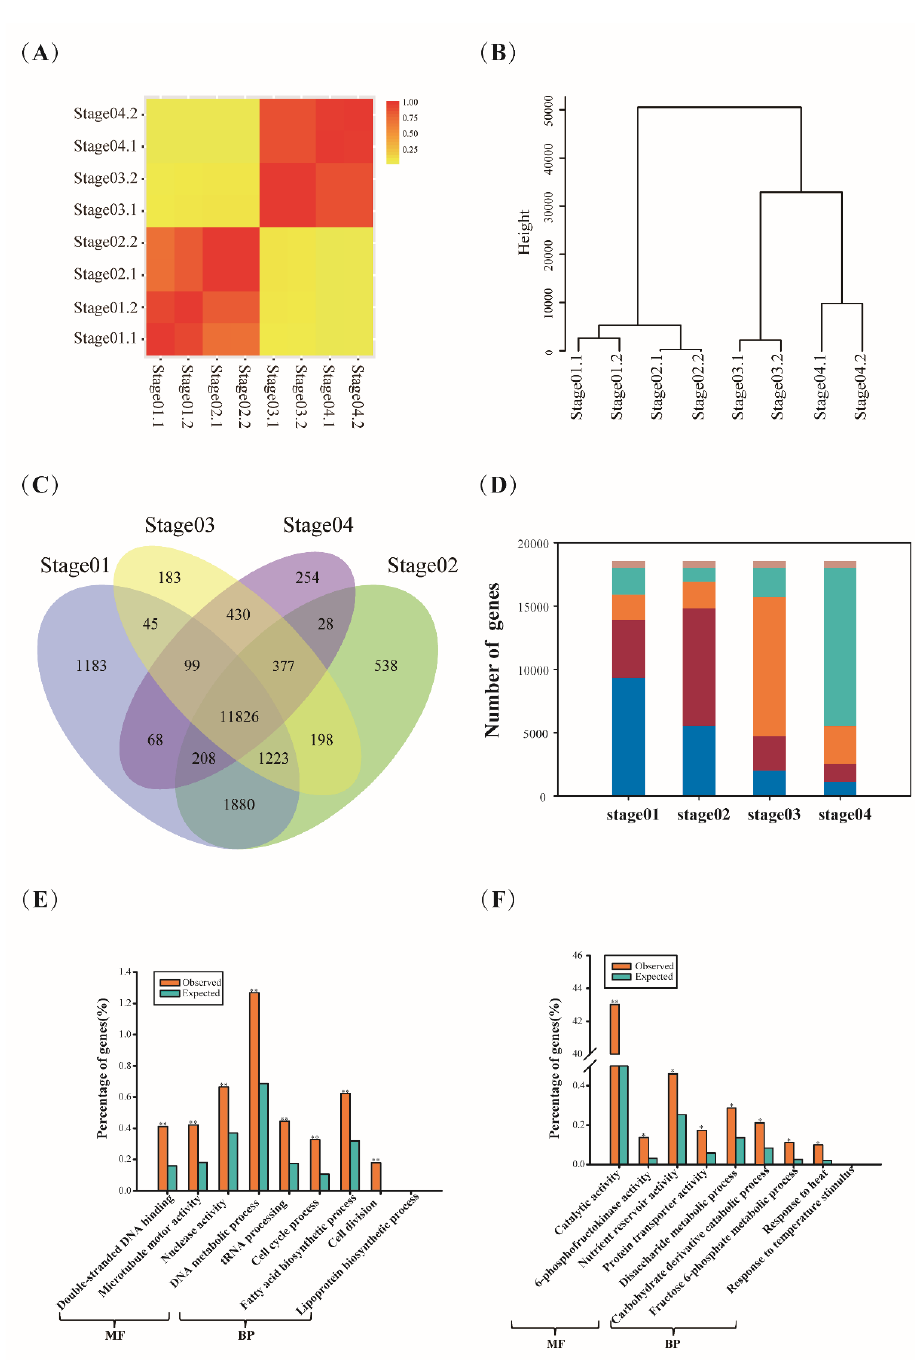
Figure 1. Global characterization of gene expression patterns during the four stages of barley grain development. ( A ) Correlation coefficients between gene expression data sets from two biological duplicates and stages. ( B ) Cluster dendrogram showing global relationships of gene expression in different stages. The branch length indicates the degree of variance. ( C ) Venn diagram analyses of stage-specific genes in barley. ( D ) Overview of genes with different activity degree among the four stages. The different number suggests different activity ranking at each stage and the activity degree decreases as the number increases. For example, ‘1′ indicates gene showed the most activity at this stage and ‘4′ suggests the most inactive stage. ( E ) to ( F ) Functional categories of genes showing peak expression at the prestorage phase (stage01 and stage02) ( E ) and storage phase (stage03 and stage04). ( F ) Padj-adjusted p values, * p < 0.05 and ** p < 0.01. Observed, numbers of genes observed in this study; Expected, numbers of genes in this same category of annotated barley gene